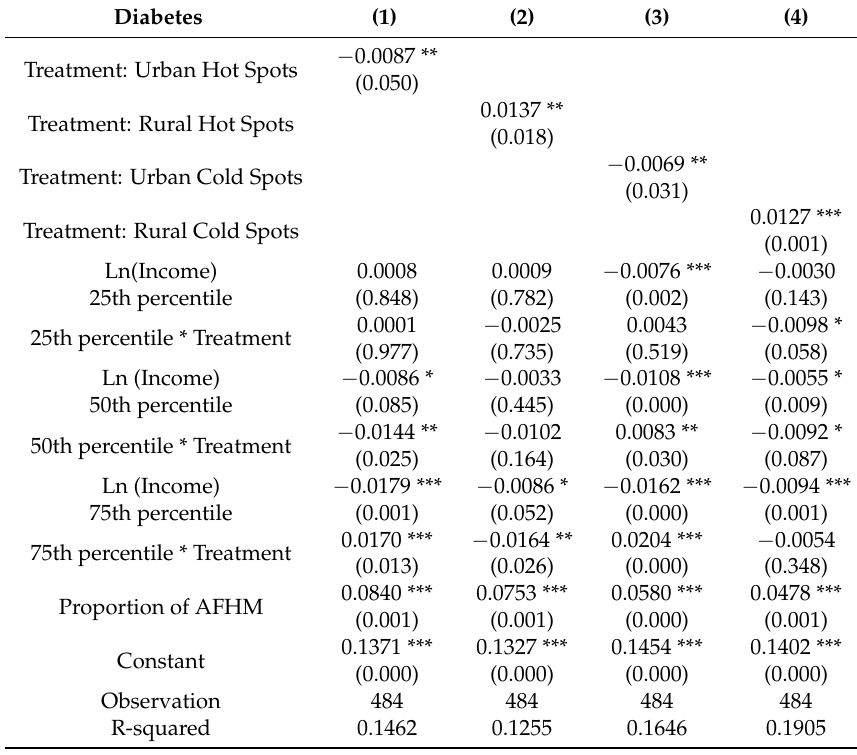
Table A9. The impacts of urban and rural hot (and cold) spots on diabetes